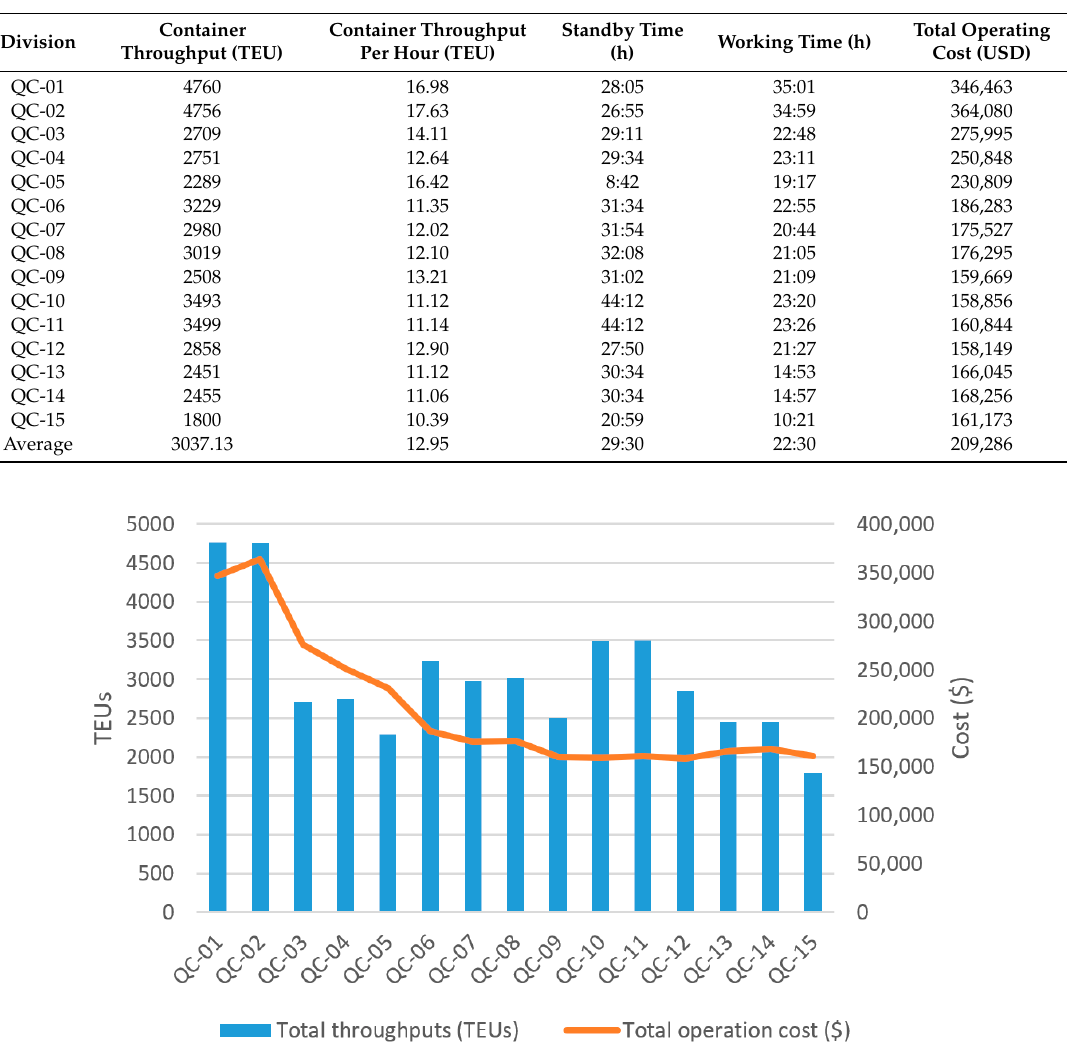
Table 5. Simulation results of virtualized port-container terminal (quay crane).